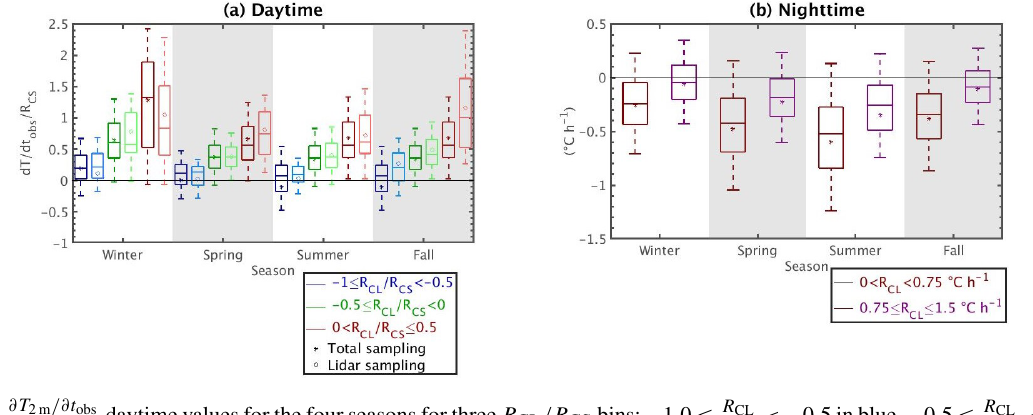
Figure 8. (a) ∂T 2m /∂t obs daytime values for the four seasons for three R CL /R CS bins: − 1 . 0 ≤ R CL R CS ≤ 0 . 5 in red. Dark-colored boxplots with the mean represented as “ ∗ ” correspond to cases when all meteorological variables are and 0 < R CL R CS available at the same time (without considering lidar availability), whereas light-colored boxplots with “ ◦ ” as their mean value represent the sample when both all meteorological variables and lidar profiles are available simultaneously. (b) ∂T 2m /∂t obs nighttime values for two R CL bins: 0 ◦ Ch − 1 <R CL < 0 . 75 ◦ Ch − 1 in maroon and 0 . 75 ≤ R CL ≤ 15 ◦ Ch − 1 in purple. Distributions are represented by box-and-whisker plots, where the boxes indicate the 25th and the 75th data percentiles, the whiskers indicate the 5th and 95th percentiles, the middle line represents the median, and the ∗ or ◦ is the mean. Negative and close-to-zero values are removed (see text for further information).